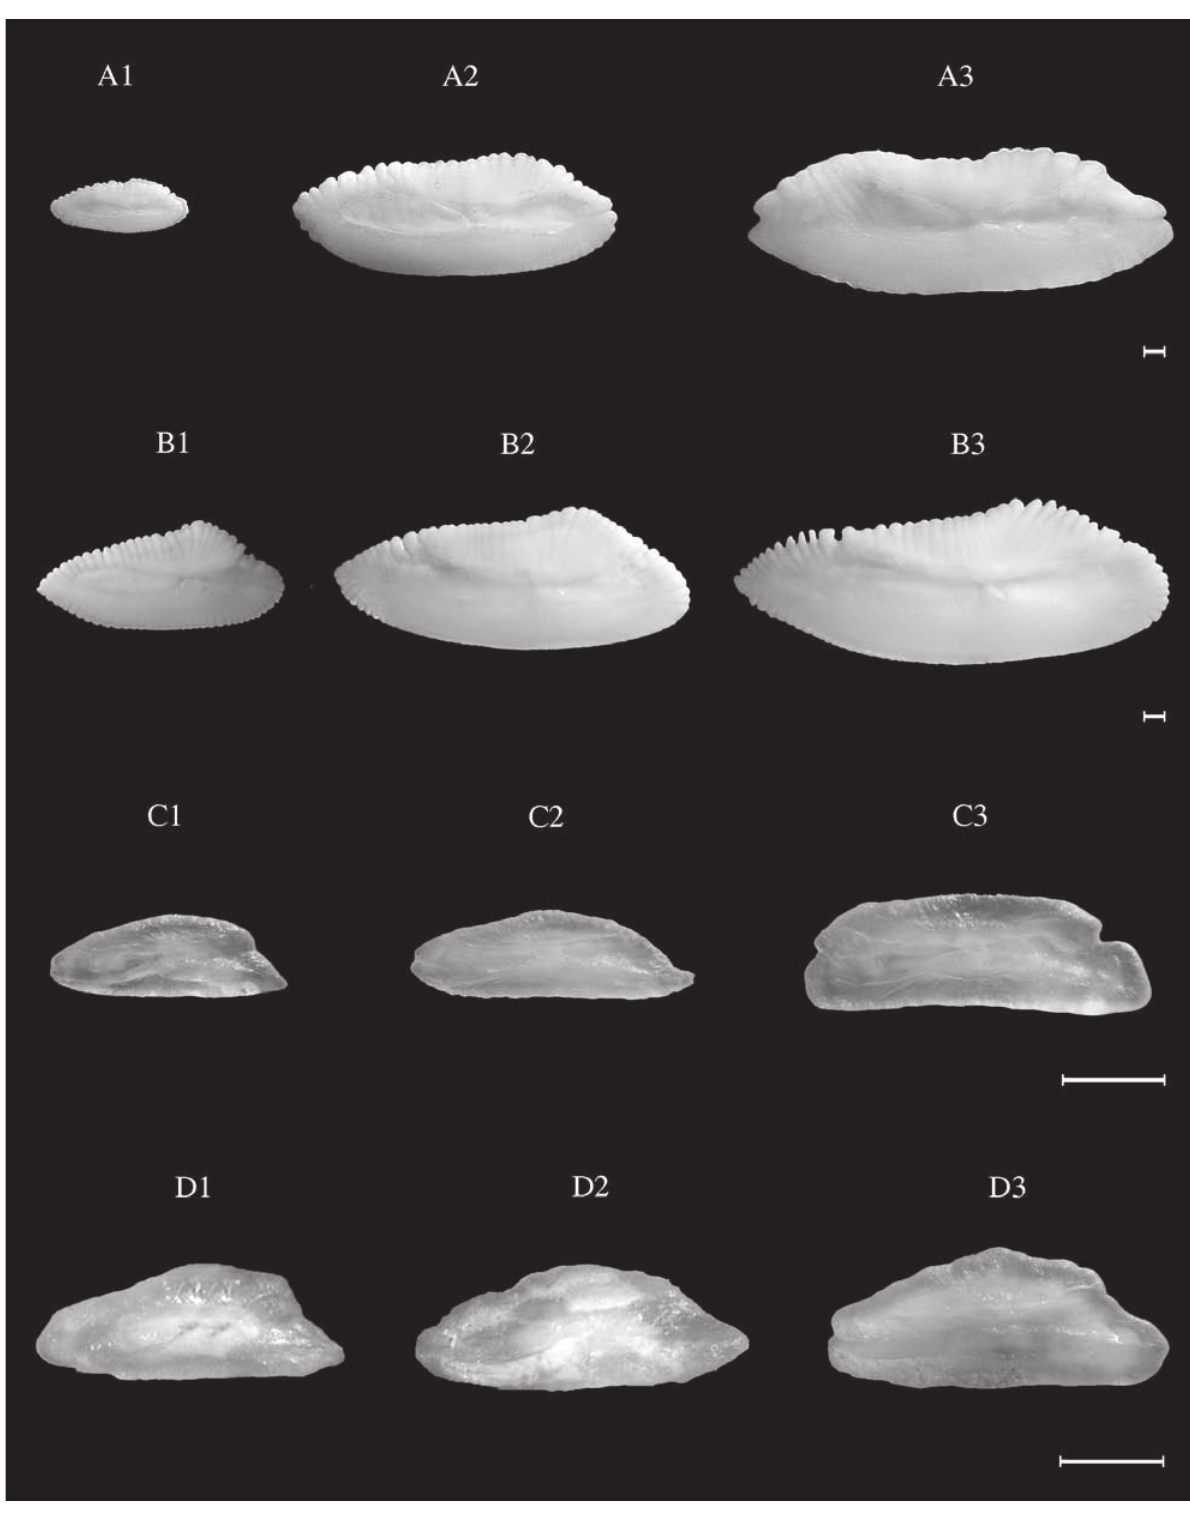
Fig. 29. – Merluccius polli (CEA). TL: A1, 14.1 cm; A2, 29.4 cm; A3, 55.2 cm. Merluccius senegalensis (CEA). TL: B1, 25.6 cm; B2, 40.2 cm; B3, 56.9 cm. Ciliata mustela (NEA). TL: C1, 11.8 cm; C2, 14.5 cm; C3, 22.2 cm. Gaidropsarus biscayensis . TL: D1, 10.5 cm (WM); D2, 13.0 cm (WM); D3, 16.4 cm (NEA). Scale bar = 1